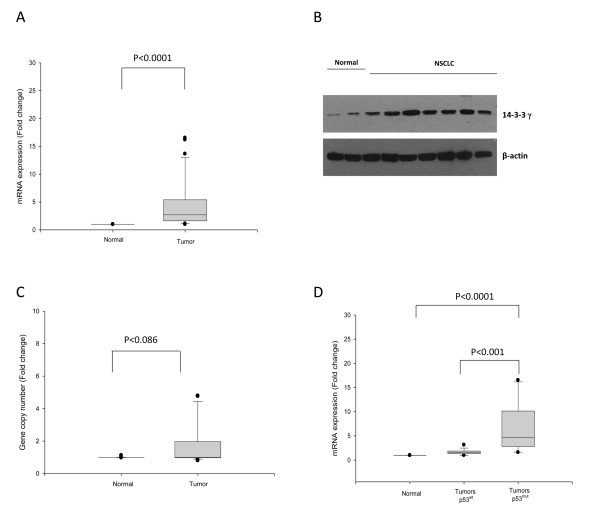
Elevated expression of 14-3-3γ correlates with mutations in p53. A. mRNA expression in NSCLC tumors. RNA was extracted from frozen specimens of normal and tumor tissues and the quantity of 14-3-3γ determined using quantitative RT-PCR. Fold changes were determined by 2-ΔΔCt by comparing Ct values of 14-3-3γ with GAPDH. The box plot depicts 2-ΔΔCt values for 14-3-3γ expression. p-values are for comparison of the levels of 14-3-3γ mRNA in tumor specimens with normal tissue, which is calculated using ΔCt values. B. Analysis of 14-3-3γ expression by Western blotting in NSCLC tumors. A Western blot showing expression of 14-3-3γ protein in 8 representative NSCLC tumors and protein loading was confirmed by β-actin. C. Gene copy number. Genomic DNA was extracted from normal and tumor tissues and the relative quantity of 14-3-3γ DNA determined using quantitative PCR from equal quantities of DNA. ΔCt values for 14-3-3γ were normalized against PI3KR1 (p85alpha regulatory subunit of PI3K) since the latter was found to be unaltered in NSCLCs. The fold changes were calculated by comparing normal and tumor tissues using 2-ΔΔCt. Y-axis shows the fold change comparing normal and tumor tissues. D. 14-3-3γ expression and p53 mutations in NSCLC tumors. p53 mutational status was determined in the same lung tumors used in panels A and B using RT-PCR amplification of p53 mRNA followed by direct sequencing. Tumors were then segregated based on p53 mutation status, (wt-p53) or (mut-p53) and the 14-3-3γ mRNA expression determined as in panel A. p-values were determined by comparing normal tissue, tumors with wt-p53 and tumors with mut-p53.